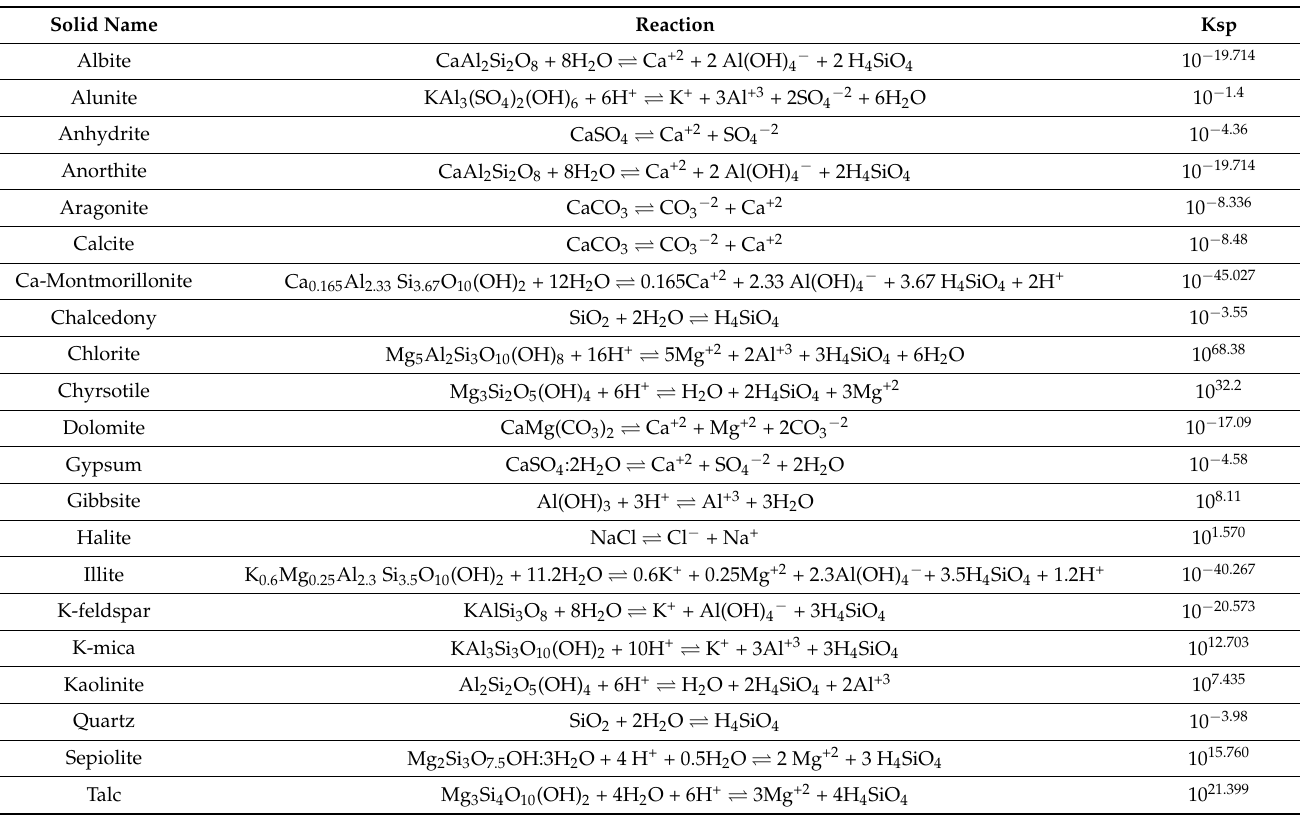
Table 4. Various solids species that could precipitate in the formation, chemical reactions with solubility product at 25 ◦ C [36]. Solid Name